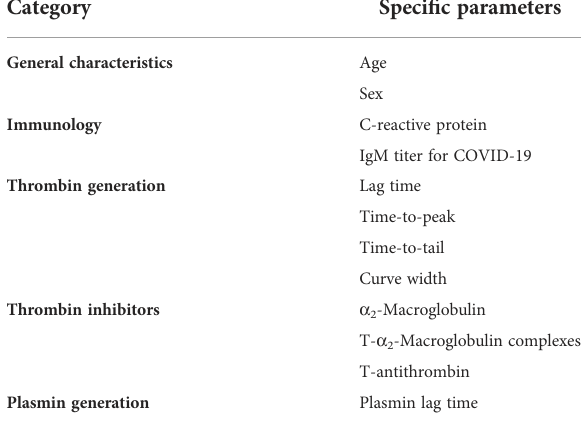
TABLE 3 Input parameters for the neural network.